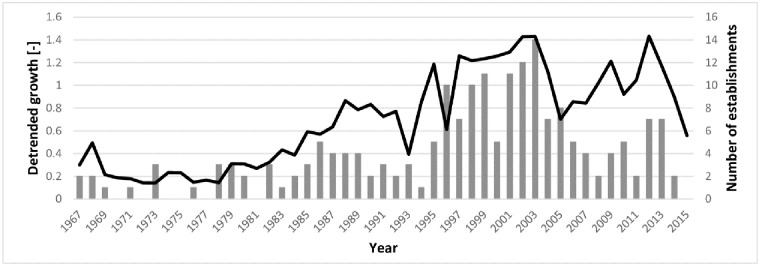
Establishments (bars) as determined through tree-ring measurements (i.e. age), and the average growth rate (line) of all samples combined (N = 196).